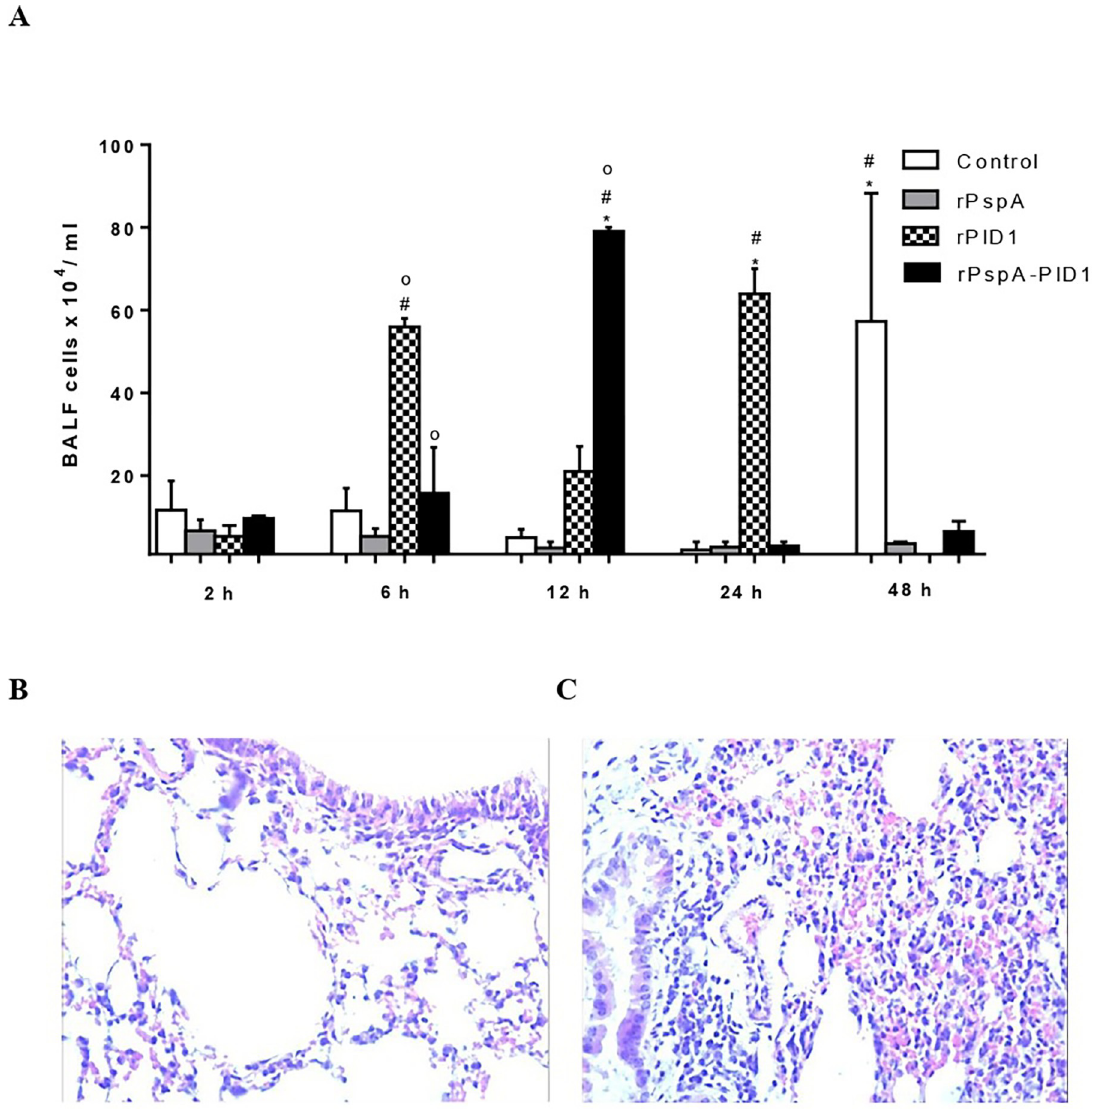
Fig 3. Induced immune responses in lungs and BALF. (A) Cellular infiltrate in the BALF following pneumococcal challenge. Immunized and control mice were euthanized at different time points after intranasal inoculation of St 245/00 and the total cell counts in the BALF were determined and compared among immunization groups and times points. Statistical analysis was performed using ANOVA with Tukey’s and Dunnet’s posttests. ( � ) p < 0,05 between samples from the same immunization group at different times after challenge; (#) p < 0,05 in comparison with the control (Alum) at the same time point; (o) p < 0,05 when comparing immunization with rPspA-PlD1 versus isolated proteins at the same time point. (B and C) Histological analysis of lung tissue after pneumococcal challenge. 1 μ m sections of the left lung lobe from mice immunized with the hybrid (B) and from control mice (C) after 48 h were stained with hematoxylin-eosin, showing slight and moderate levels of inflammation, respectively (Original magnification,